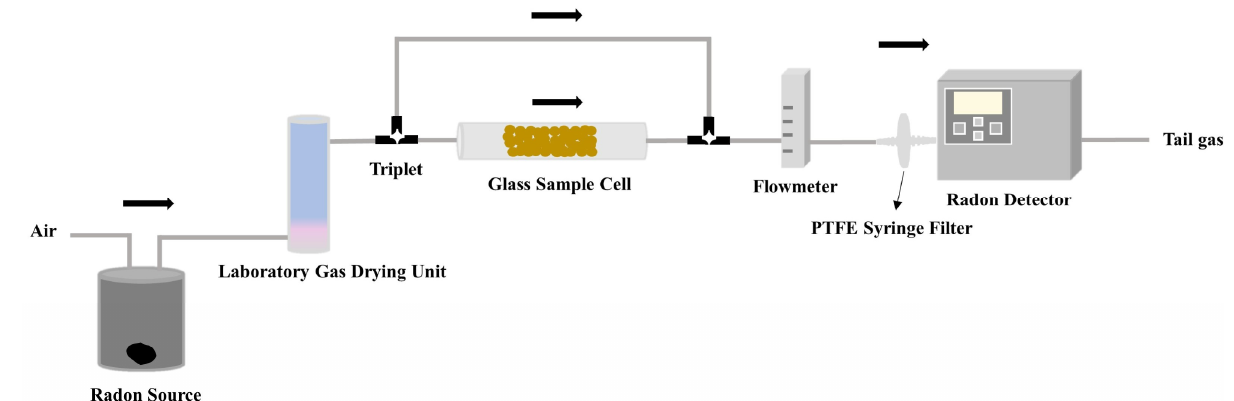
Figure 3. Schematic of the radon breakthrough experiment.